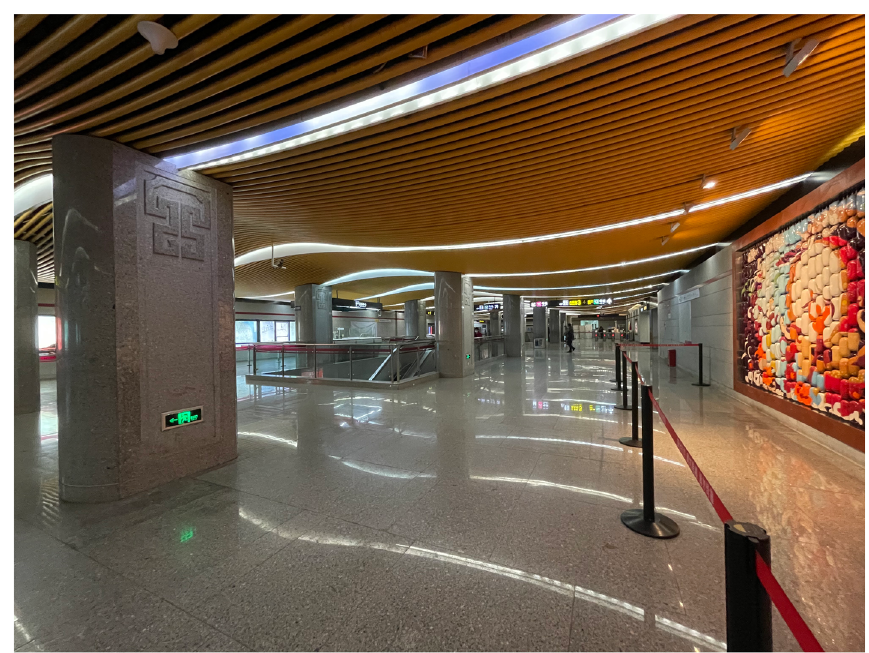
Fig. 7 Buddhist mural representation (right) and traditional design carvings in the stone cladding of pillars (left) at Longhua Road Metro Station (Line 11). (Source: the